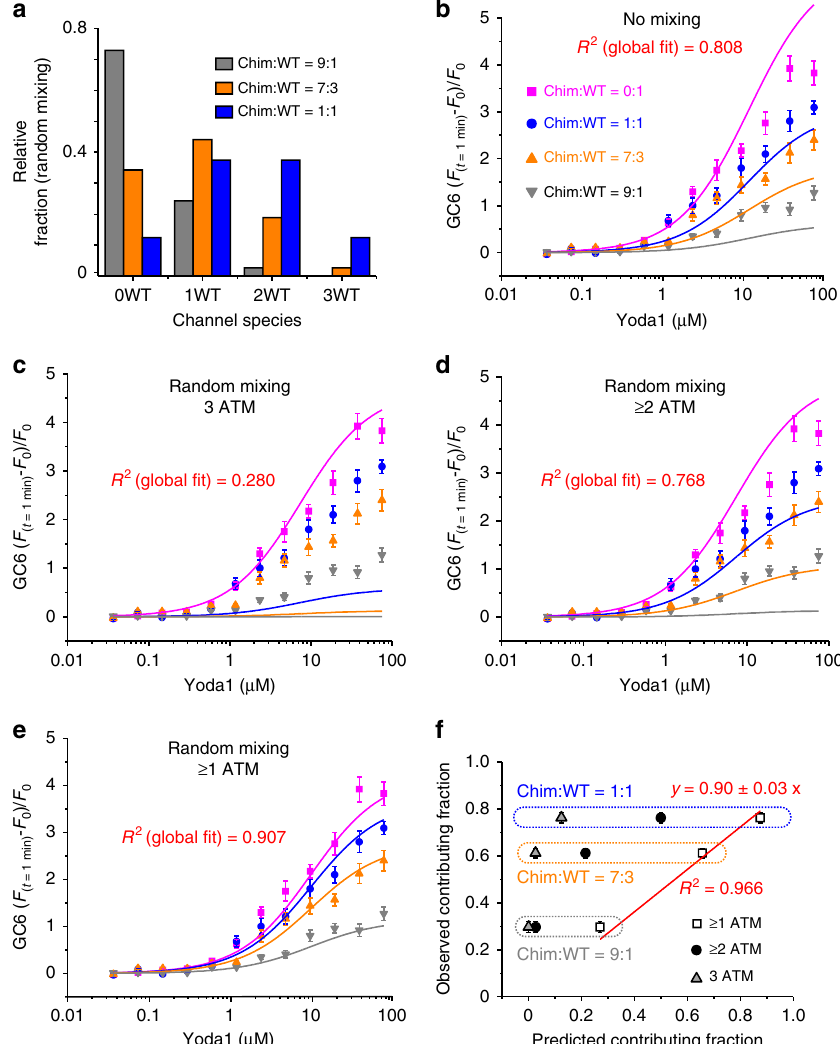
Fig. 5 Global fi tting of Yoda1 dose – responses from hybrid channels. a Predicted distribution of channels species for the indicated Chim:WT ratios calculated using Eq. 5. b – e Yoda1 dose – responses from cells transfected with the indicated Chim:WT ratios (0:1, magenta; 1:1, blue; 7:3, orange and 9:1, dark gray). The experiment was done in duplicate and repeated fi ve times. The data were fi tted with four different gating models using Equation 6. In b , the model assumes no subunit mixing, thus the fl uorescence signal is predicted to be contributed by WT channels whose relative proportion is identical to the proportion of transfected WT plasmid. In c – e , the models assume random subunit mixing with relative distributions as depicted in a . These models predict that the fl uorescence signal is contributed by channels harboring 3 WT subunits (3 ATM) ( c ), or at least two WT subunits ( ≥ 2 ATM) ( d ) or at least one WT subunit ( ≥ 1 ATM) ( e ) (see Table 1 for more details). f The observed contributing fraction of Yoda1-activated channels is plotted against the predicted contributing fraction of Yoda1-activated channels using Equation 7 and for three different Chim:WT ratios (1:1, blue; 7:3, orange and 9:1, gray). The predicted fractions were calculated assuming random subunit mixing and assuming signal contribution by channels having 3 ATM (gray triangles), at least 2 ATM (black circles) or at least 1 ATM (open squares). In b – f , error bars = contributing fraction for three Chim:WT ratios (i.e., 1:1, 7:3 and 1:9) by calculated the sum on the right of Equation 6 with the assumptions that the observed signal is contributed by channels ¼ observed contributing fraction ð 7 Þ Þ containing more than one ( α = β = γ = 1), more than 2 ( α = 0; β = γ = 1) or 3 WT subunits ( α = β = 0; γ = 1) (Fig. 5f). The With Δ F / F 0(mix) the calcium fl uorescence signal observed when mixing WT and chimeric subunits and Δ F / F 0(WT) the calcium fl uorescence signal observed for WT channels. We determined the observed contributing fraction by calculating this ratio for each Ch:WT ratio. This number was averaged from the observed Δ F / F 0 obtained for six tested Yoda1 concentrations ranging between 2 and 75 µM. We next calculated the predicted